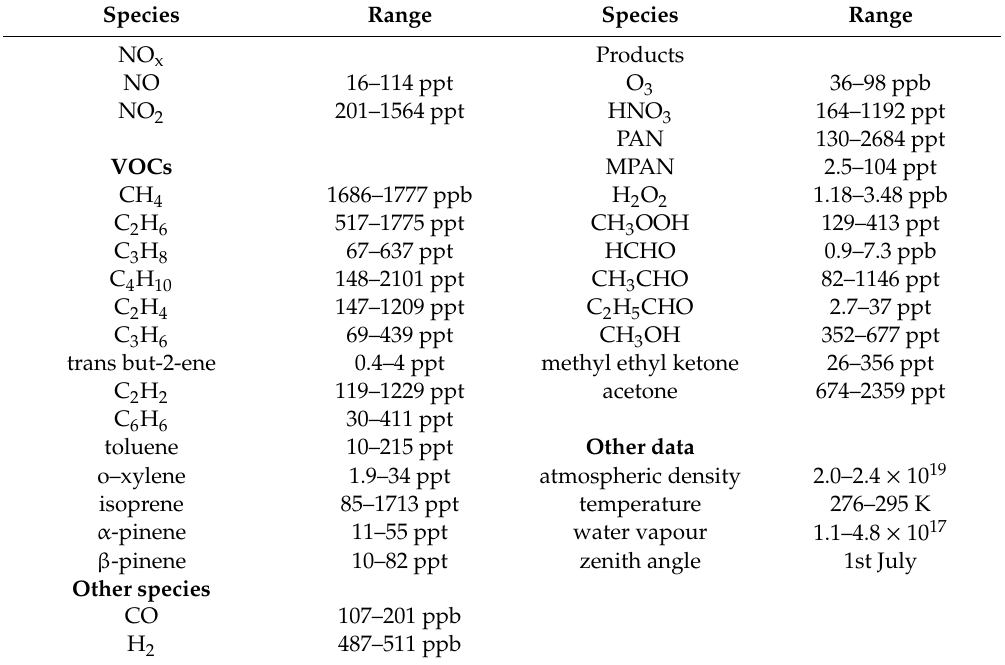
Table 2. Mixing ratios and environmental conditions employed to set up the box model study, together with atmospheric densities and water vapour concentrations in molecule cm −